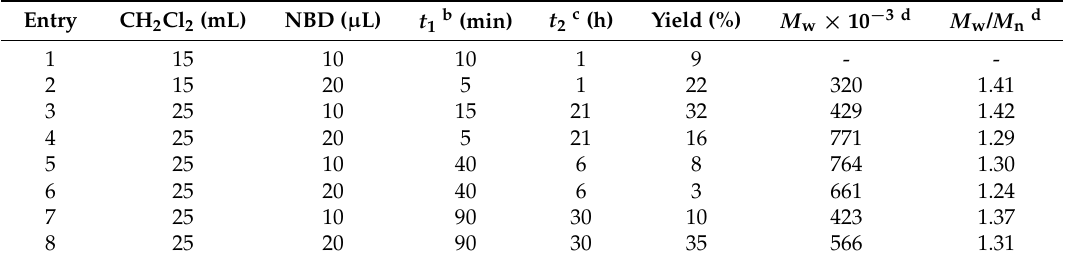
Table 4. Formulations and results of the “core-first” method at {W 2 }/NBE molar ratio 1/500 in CH 2 Cl 2 a . Entry